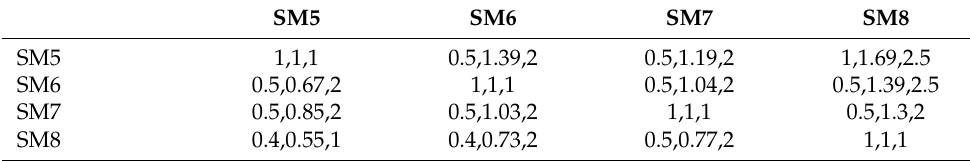
Table 15. FPCM for Quality of Data.